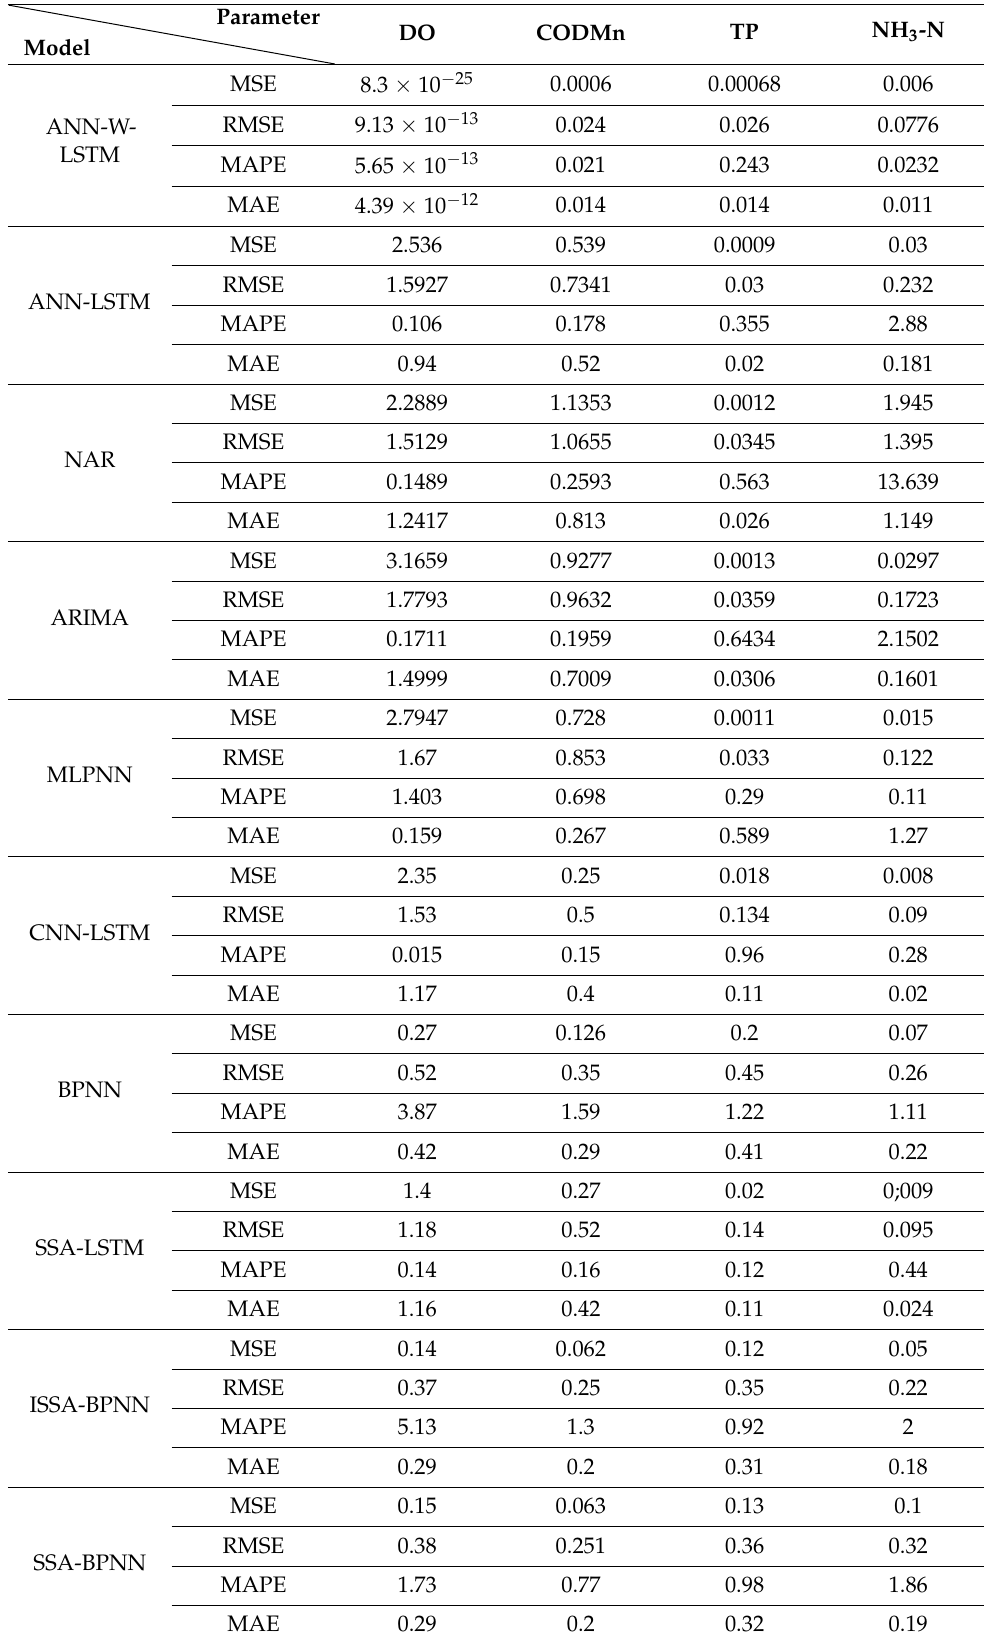
Table 6. Analysis and comparison of ANN-WT-LSTM model and other models on dataset.